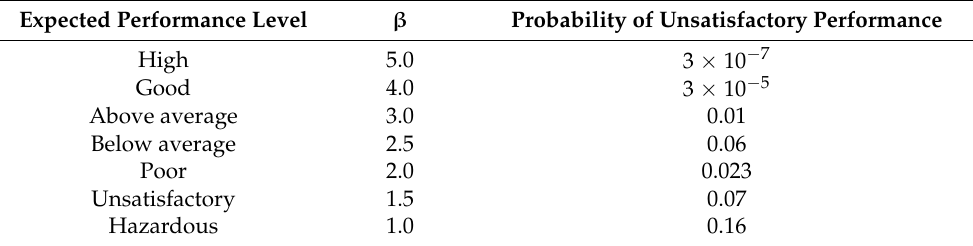
Table 5. Expected performance level according reliability indexes